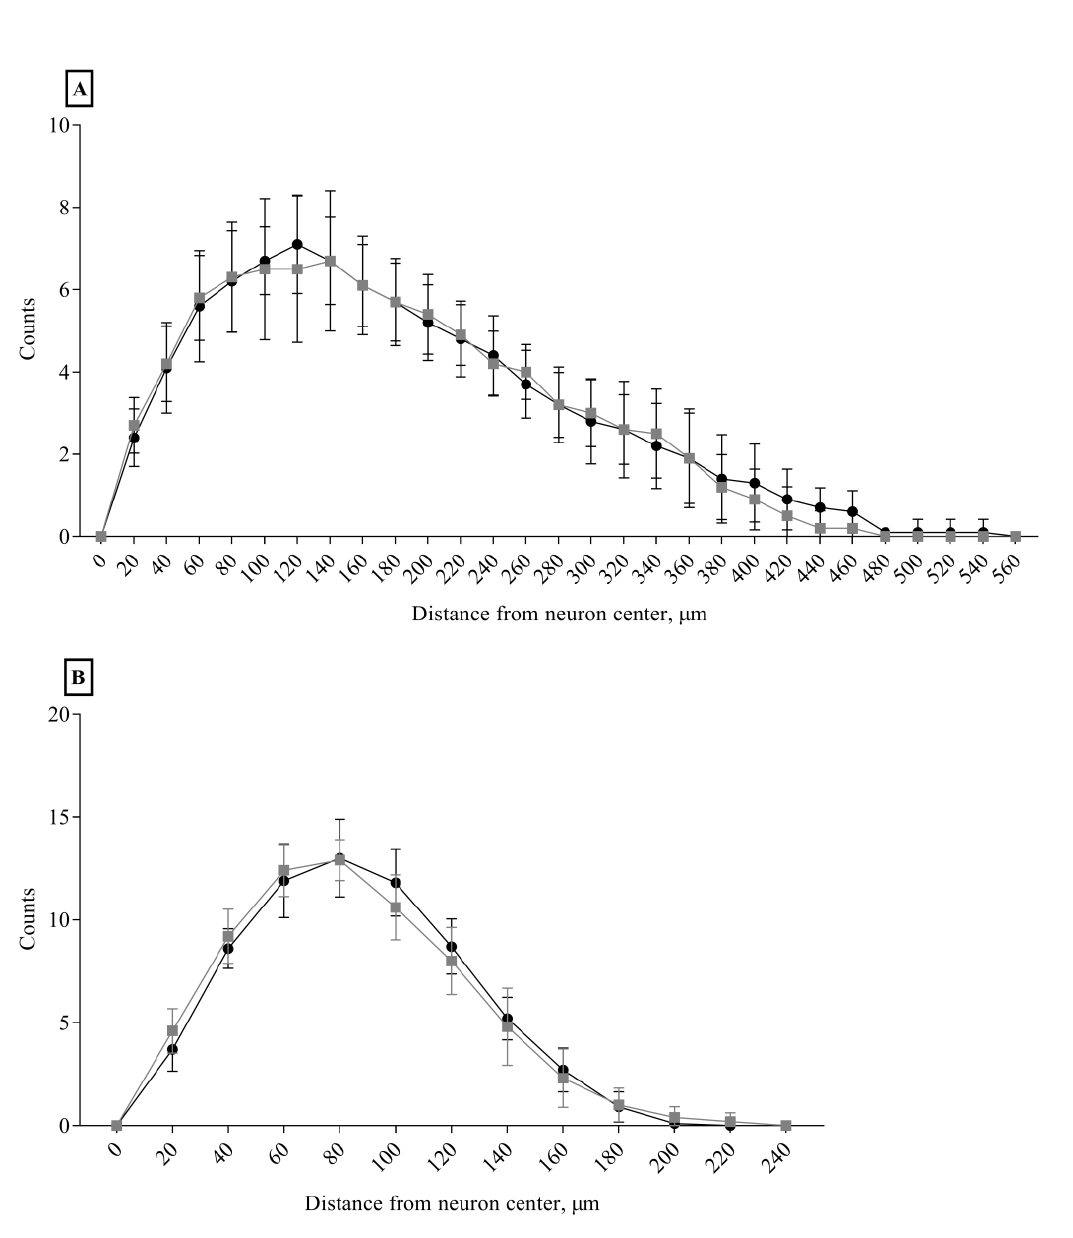
Figure 6. Sholl analysis of apical and basal dendrites of cornu ammonis 1 pyramidal neurons. Apical ( A ) and basal ( B ) cornu ammonis 1 pyramidal neuron from control animals (black dots) and severely vitamin C deficient animals (gray squares). No effect of vitC deficiency was detected on the dendrite complexity measured as number of dendrite crossings on concentric circles radiating from the neuronal soma with a continuous increase in the radius of 20 µ m. Two-way repeated measures ANOVA, mean ± SD. Each experimental group consisted of 10 animals and from each animal 5–7 pyramidal neurons within the stratum pyramidale of cornu ammonis 1 were analyzed for morphological changes and the data averaged.